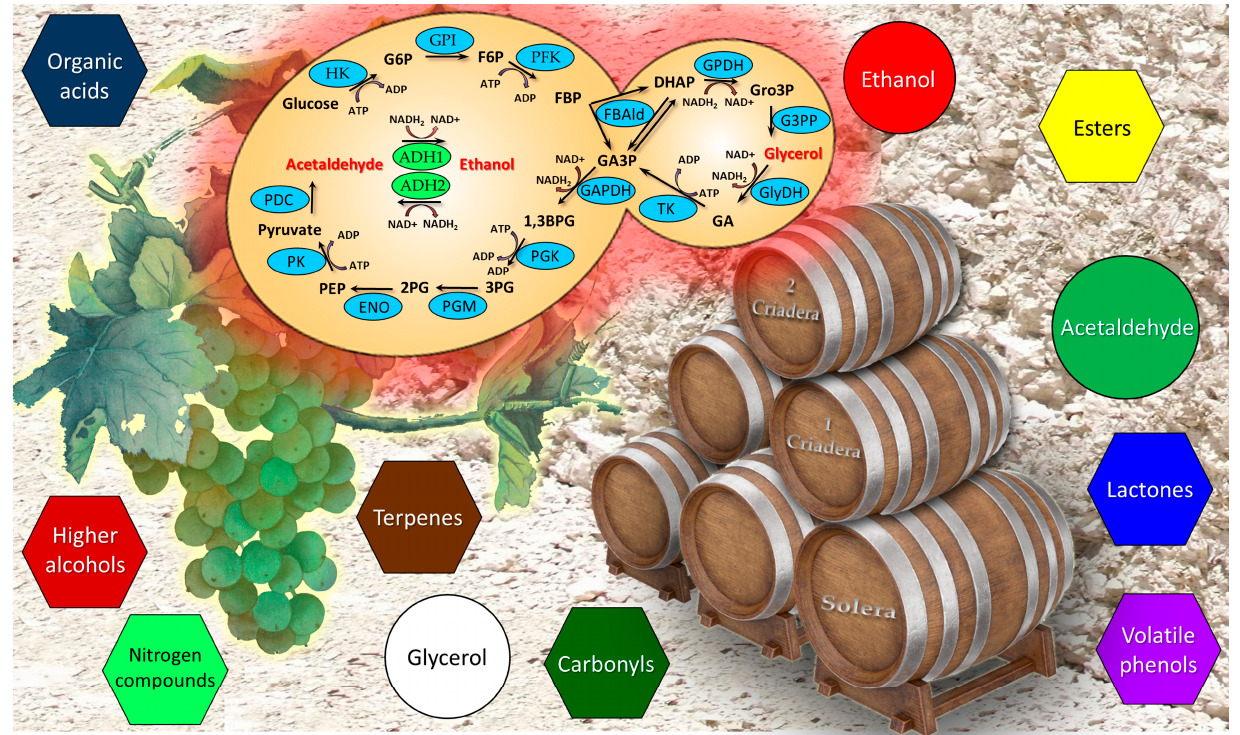
Figure 3. Major chemical compounds found in sherry wines. The names of a group of compounds are placed in a hexagon, whereas the names of individual compounds are placed in a circle. Fermentation reactions leading to the formation of glycerol, acetaldehyde and alcohol are conventionally placed in the mother and daughter cells of the budding S. cerevisiae , while all reactions occur both in the body of the mother and daughter cells. Compounds involved in metabolism: G6P—glucose